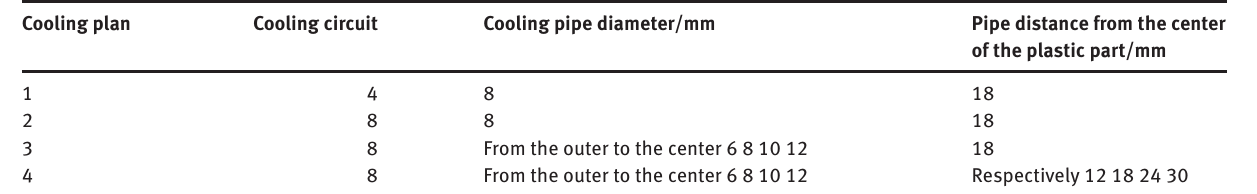
Table 4: Cooling plan parameters.